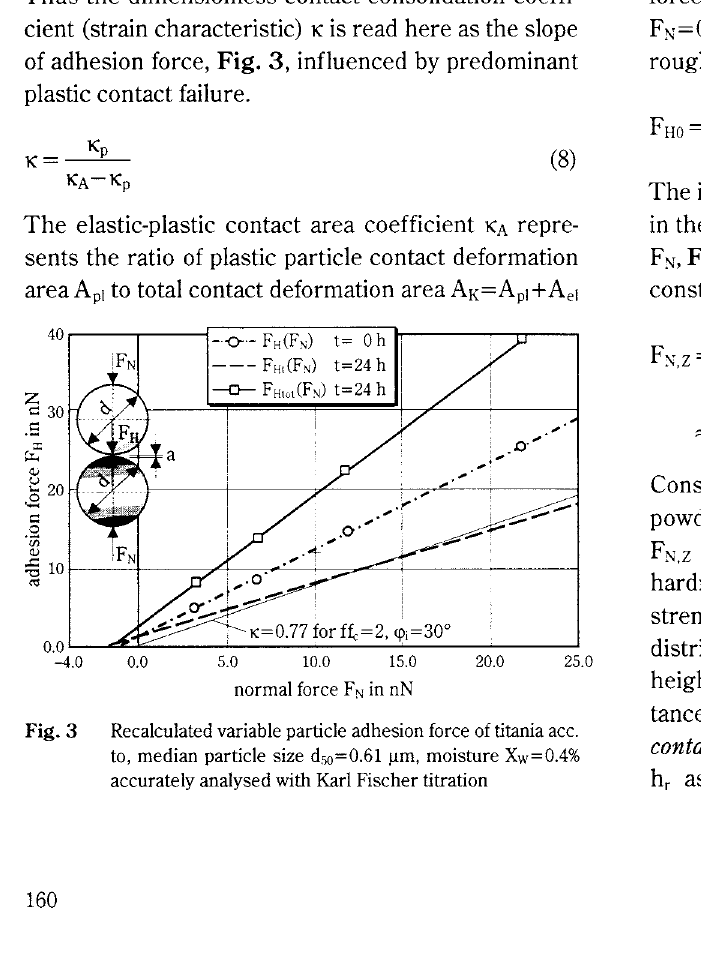
normal force F N in nN Fig.3 Recalculated variable particle adhesion force of titania ace. to, median particle size d.';0=0.61 ~m, moisture Xw=0.4% accurately analysed with Karl Fischer